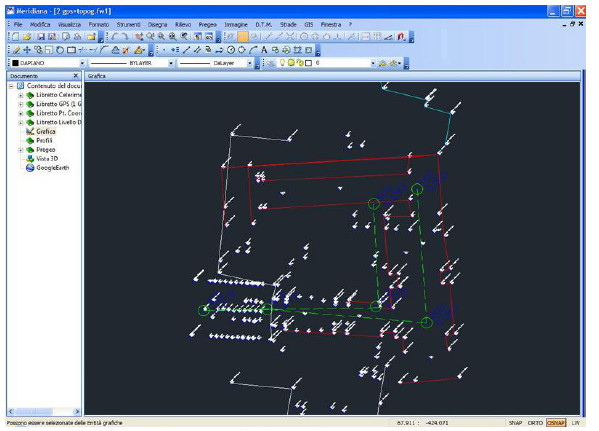
Figure 10. Graphical display within the CAD environment dedicated and enriched by specific topographic features.